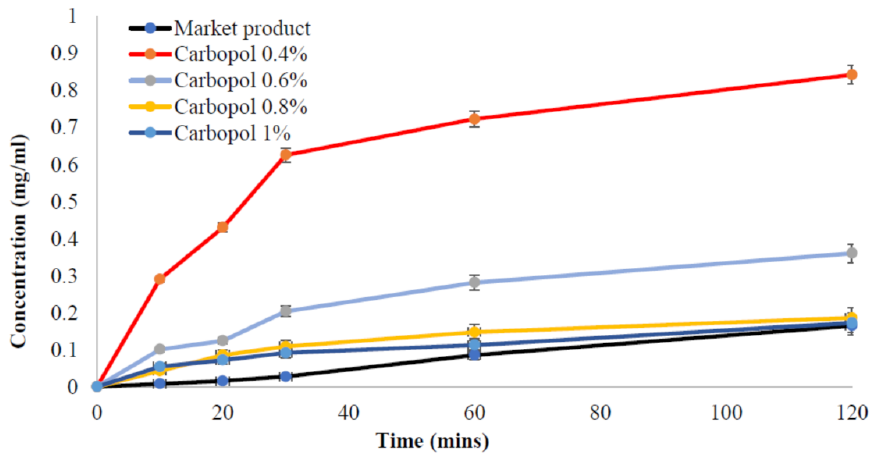
Figure 5. The release profile of Benzoyl peroxide nanoemulgels containing different Carbopol concentrations compared with the market product.